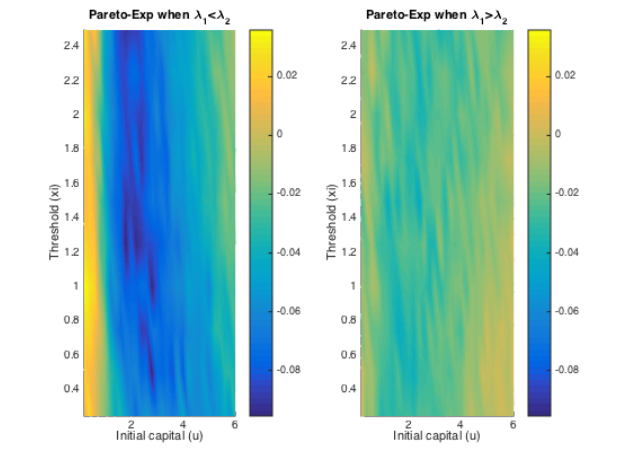
Figure 8. Differences in ruin probabilities using two claim